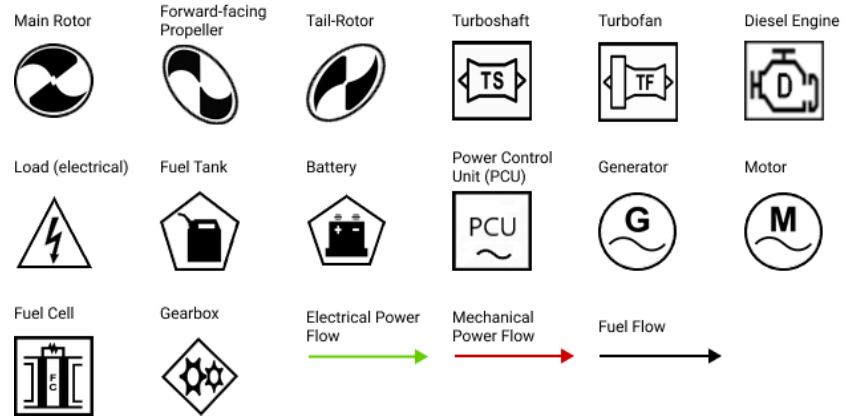
Figure 2. Adapted AIAA symbols. (From [21] and reprinted by permission of the American Institute of Aeronautics and Astronautics, Inc.).